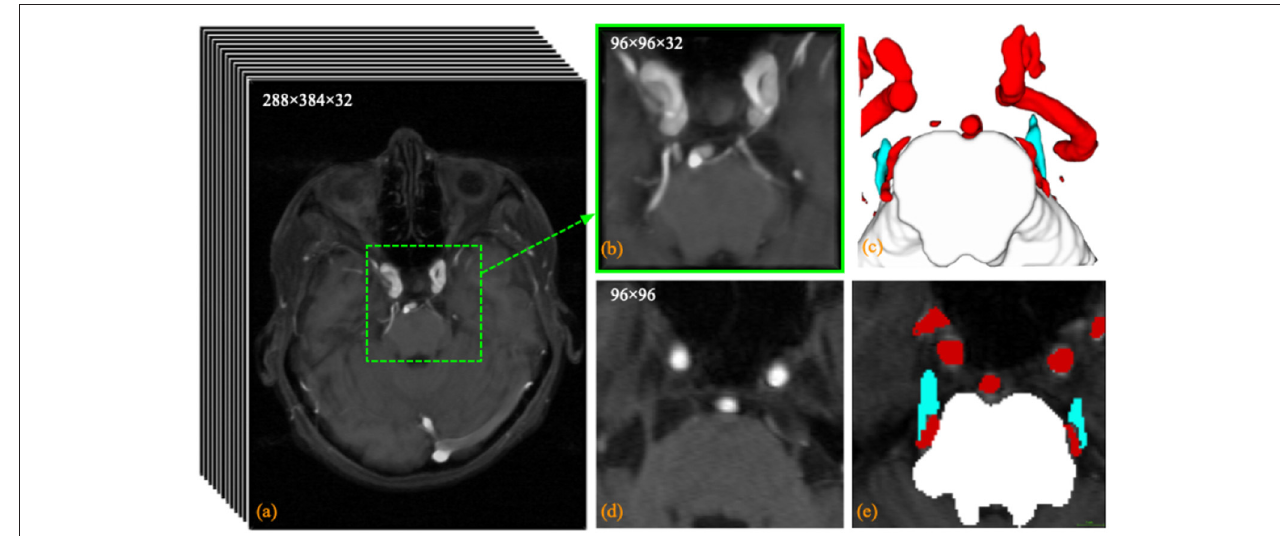
FIGURE 2 | Visualization example of the trigeminal nerve and (a) the original MRA volume; (b) the enlarged view of the central area within the dashed green box; (c) the anatomical labeling of cerebrovascular, trigeminal nerve (blue) and brainstem; (d) the 14 th slice of the MRA volume; and (e) the pixel labeling of cerebrovascular (red), trigeminal nerve (blue) and brainstem (white) in the 24 th